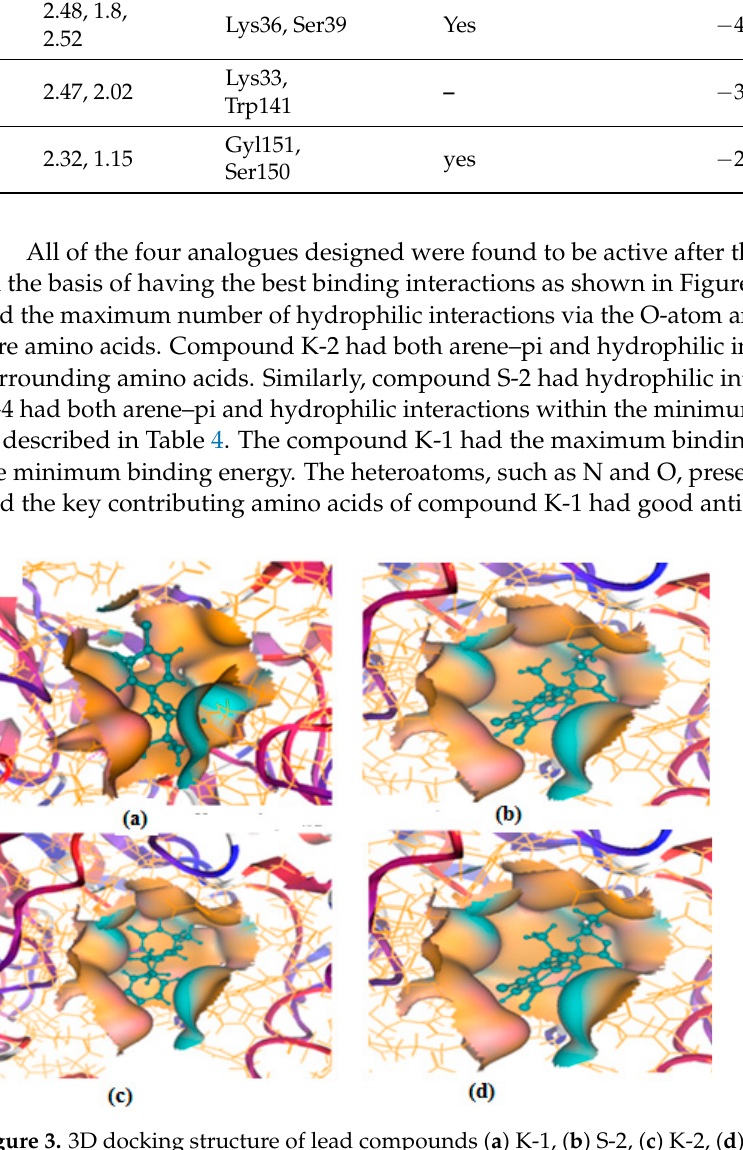
Figure 3. 3D docking structure of lead compounds ( a ) K-1, ( b ) S-2, ( c ) K-2, ( d ) H-4 in the active site of